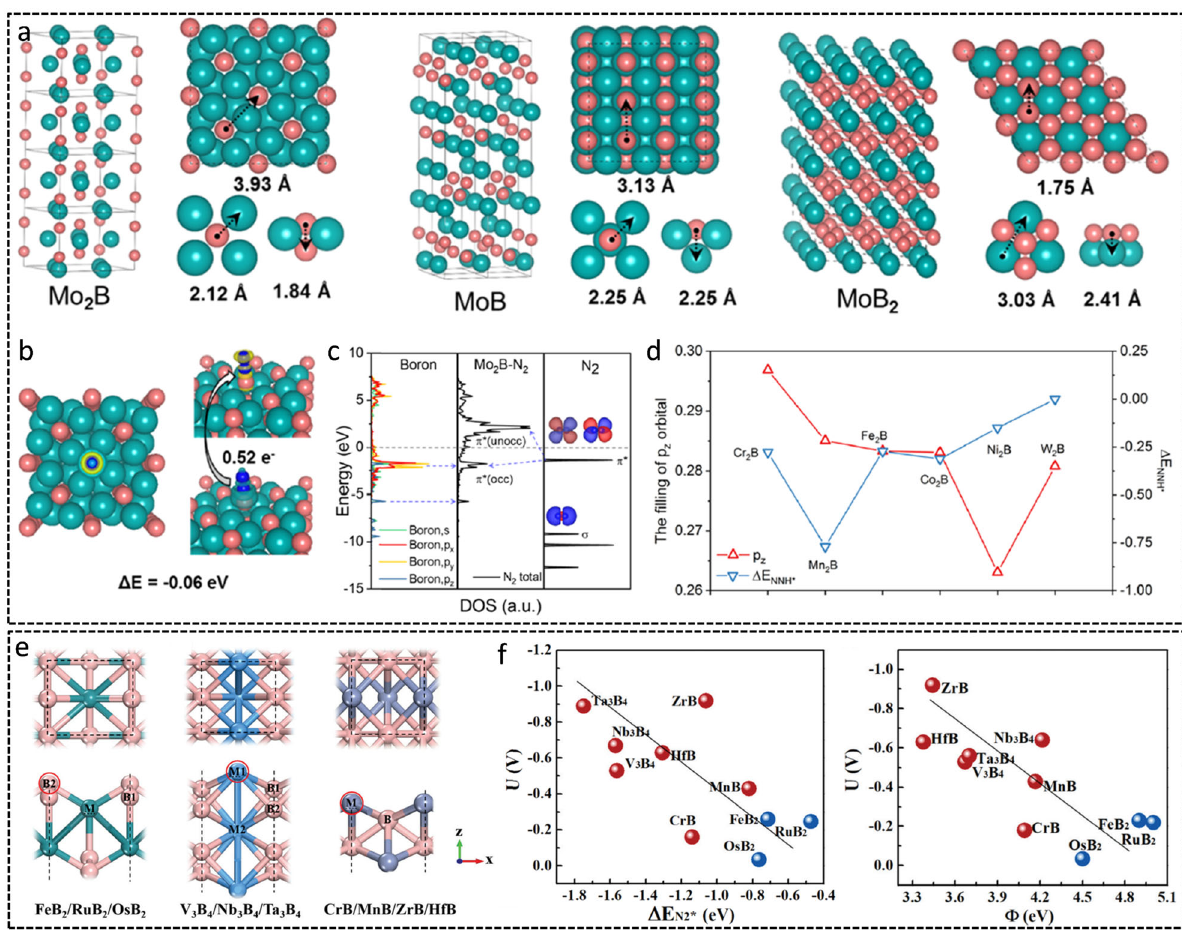
Fig. 10 Transition metal borides for NRR. a Crystal structures of Mo 2 B, α -MoB, and MoB 2 . b Charge density difference of end-on N 2 adsorption on Mo 2 B. c PDOS and schematic illustrations of B orbitals of molybdenum borides, π *-orbitals of the N 2 gas molecule, and their interactions with Mo 2 B. d Relationship between the fi lling of B p z -orbital and the adsorption energy of *NNH ( a – d are reproduced with permission from ref. 286 , Copyright © American Chemical Society 2020). e Structural prototypes of MBenes. f NRR onset potential vs. N